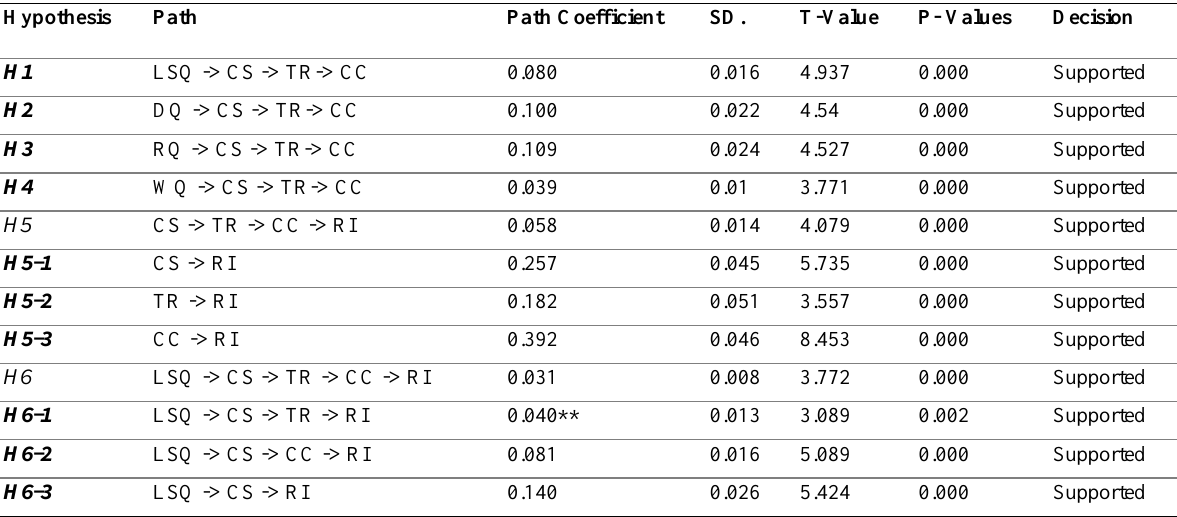
Table 4: Significance Testing Results of the Structural Model Path